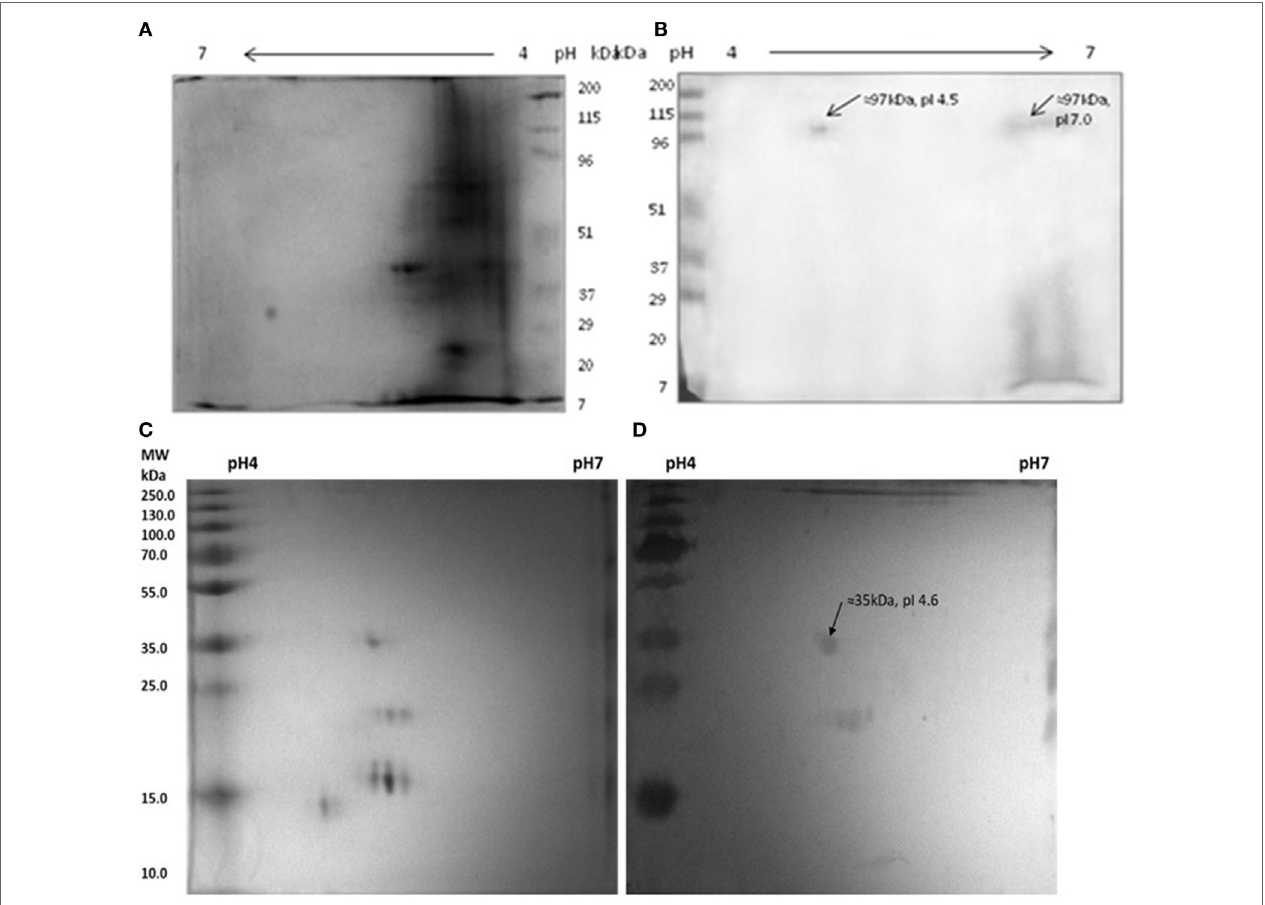
FigUre 6 | Reactivity of anti-myosin rabbit sera with Mycobacterium leprae soluble antigen (MLSA) (a,B) pooled leprosy patients’ sera with myosin (c,D) . (a) Protein profile of MLSA on 2-D gel stained with coomassie-blue, (B) Western blotting pattern of reactivity of anti-myosin rabbit sera with MLSA. (c) Protein profile of myosin on 2-D gel stained with coomassie-blue, (D) western blotting pattern of reactivity of pooled leprosy patients’ sera with